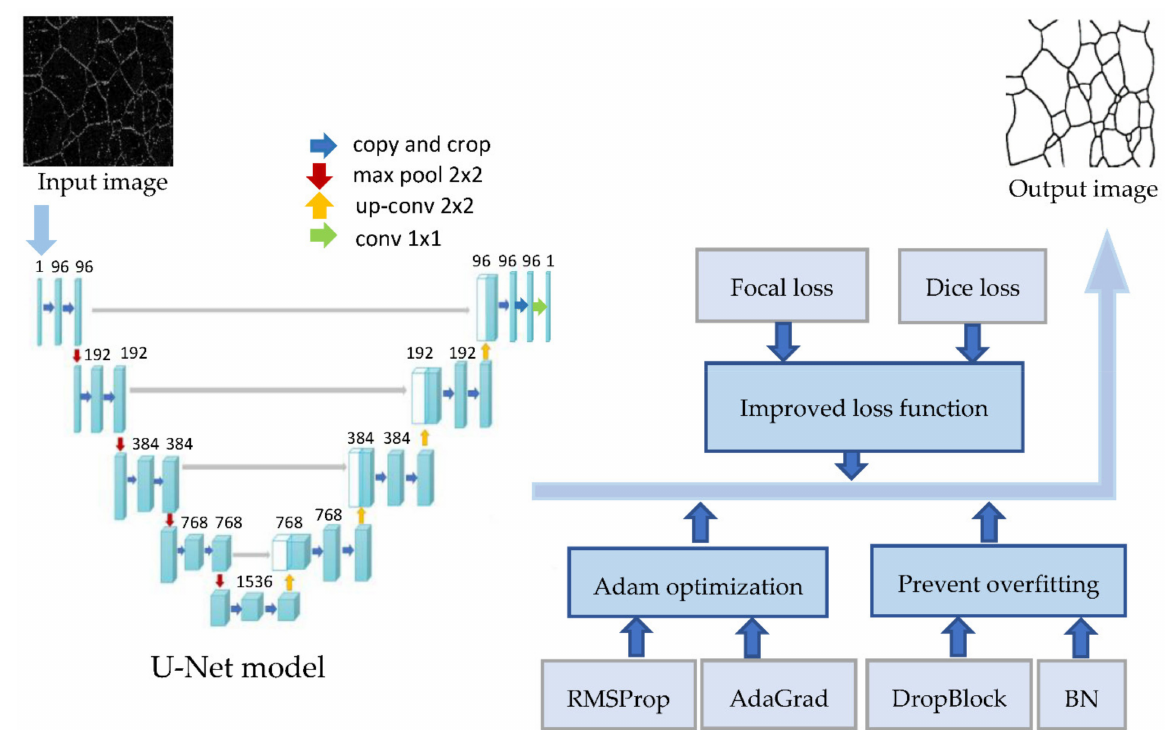
Figure 1. The structure of the improved U-Net segmentation